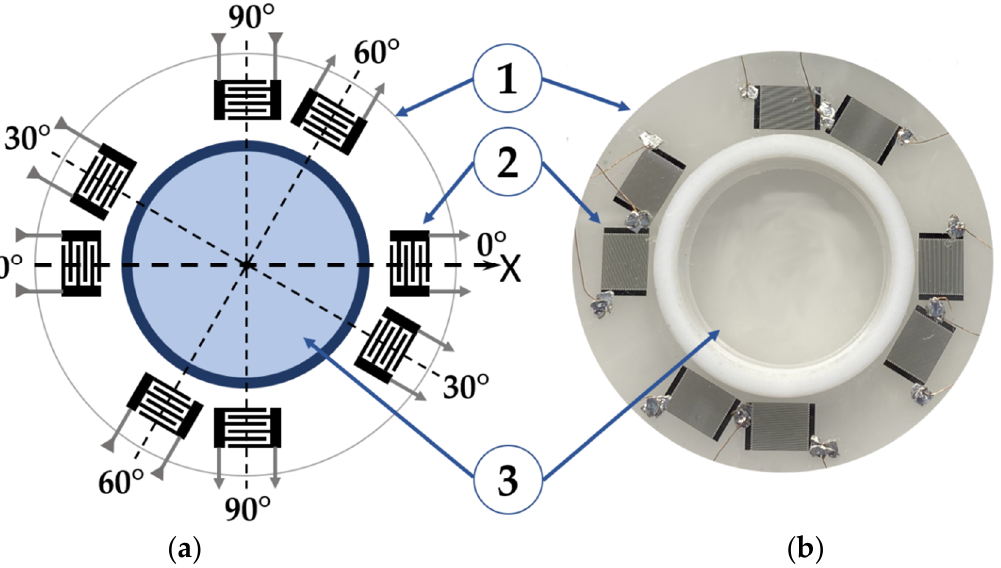
Figure 1. Schematic view ( a ) and photo ( b ) of experimental sample with 4 acoustic delay lines arranged on same piezoelectric plate; 1—plate; 2—interdigital transducers (IDTs); 3—liquid cell. Acoustic plate modes propagate in the plate at angles 0°, 30°, 60°, and 90° off X axis. Table 1. The characteristics of the delay lines shown in Figure 1.